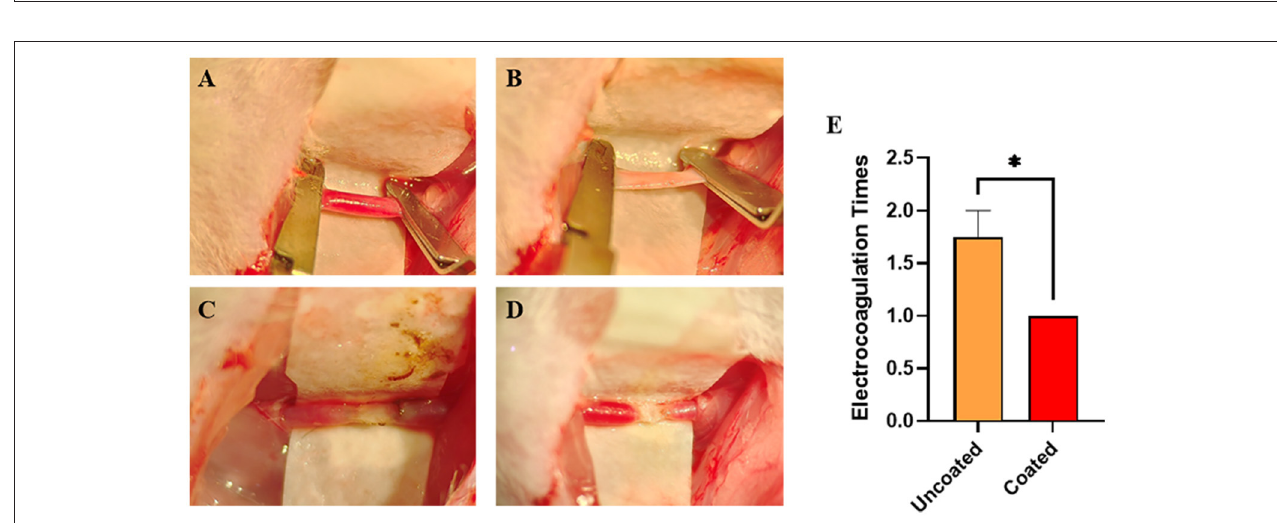
FIGURE 4 | Electrocoagulation condition of BW coated and uncoated bipolar forceps till the complete hemostasis of damaged common carotid arteries (CCAs). (A) Intact CCAs. (B) Damaged CCA with an approximately 1mm longitudinal incision. (C) Completely hemostasis with uncoated bipolar forceps. (D) Complete hemostasis with BW coated bipolar forceps. (E) Graph of the number of electrocoagulation with BW coated and uncoated bipolar forceps ( n = 4). A 2-tailed unpaired Student’s t -test, * p <